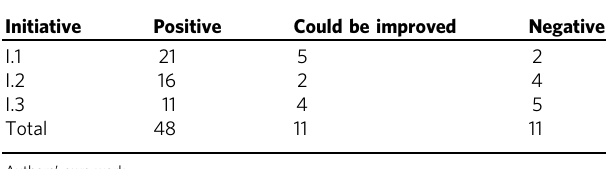
Table 10 Pupils ’ experience of collaborative work in the initiative.